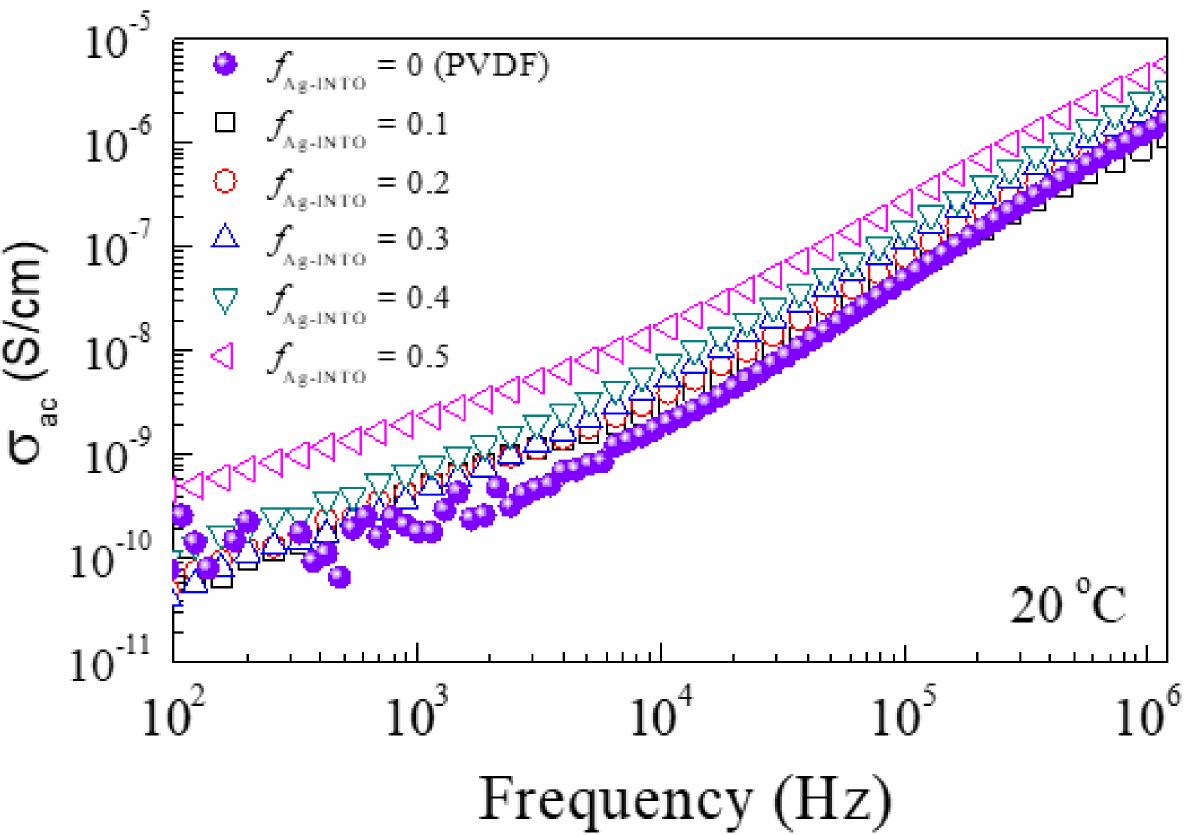
Figure 5. Frequency dependence of σ ac at 20 ◦ C for PVDF polymer and Ag − INTO/PVDF composites with different f Ag − INTO